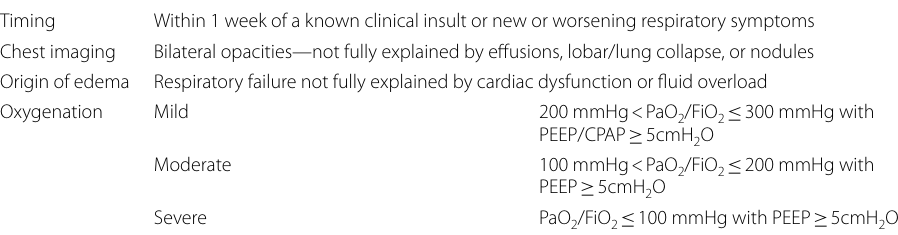
PEEP positive end expiratory pressure, CPAP continuous positive airway pressure